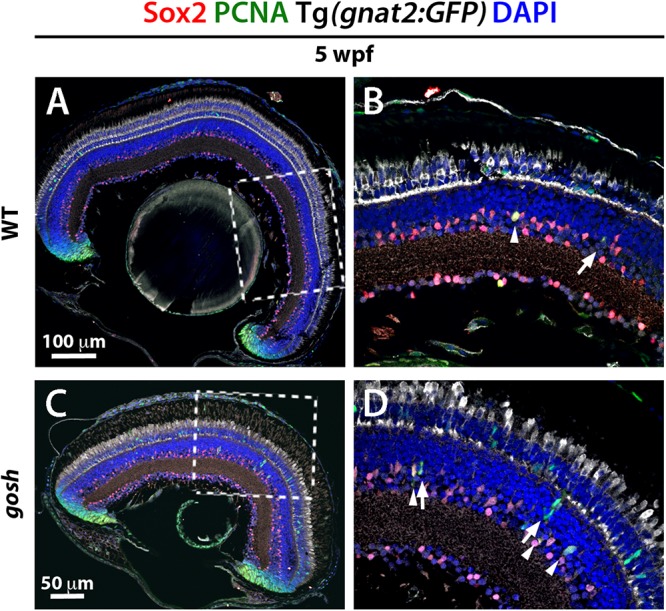
Müller glia express Sox2 during the regeneration response in gosh mutants. Wild-type and gosh mutant retinas at 5 wpf labeled with anti-Sox2 and anti-PCNA antibodies, and DAPI. Tg(gnat2:GFP) transgene visualizes cones. Wild-type retinas display Sox2 expression in the CMZ and amacrine cells (A,C, dotted boxes show the area magnifies in B,D). Müller glia exhibit faint expression of Sox2. At 5 wpf, gosh mutant retinas show that Sox2 expression is colocalized with PCNA in the INL (D, arrowheads) probably in Müller glia, whereas subsequently differentiating NPCs express only PCNA (D, arrows).